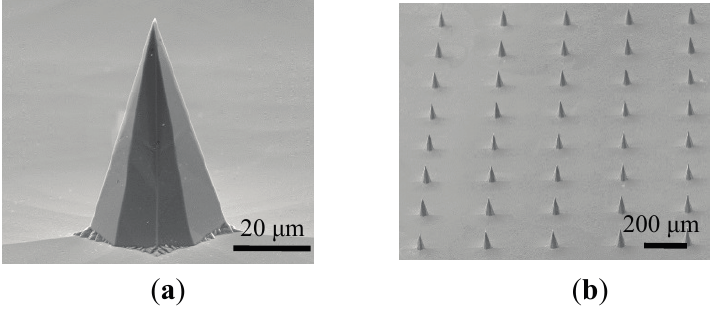
Figure 5. SEM images of the preliminary pyramidal microtips (array) after KOH anisotropic wet